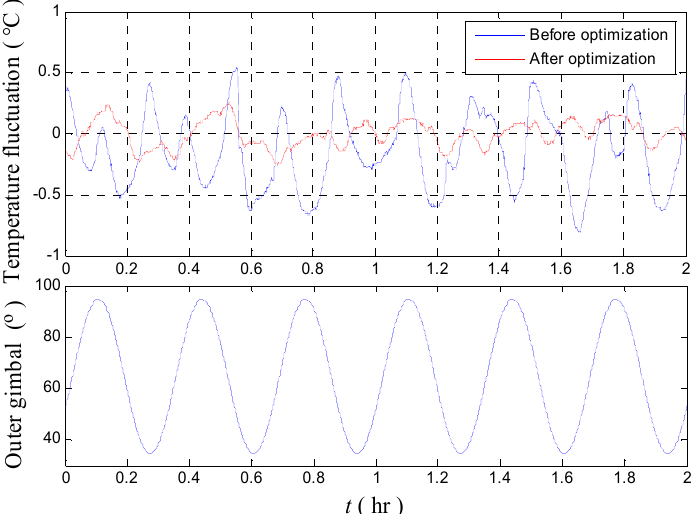
Figure 13. Temperature fluctuation of temperature control system before and after optimization in normal temperature. Table 3. Results of high–low temperature and heading rotation tests of INS before and after optimization.